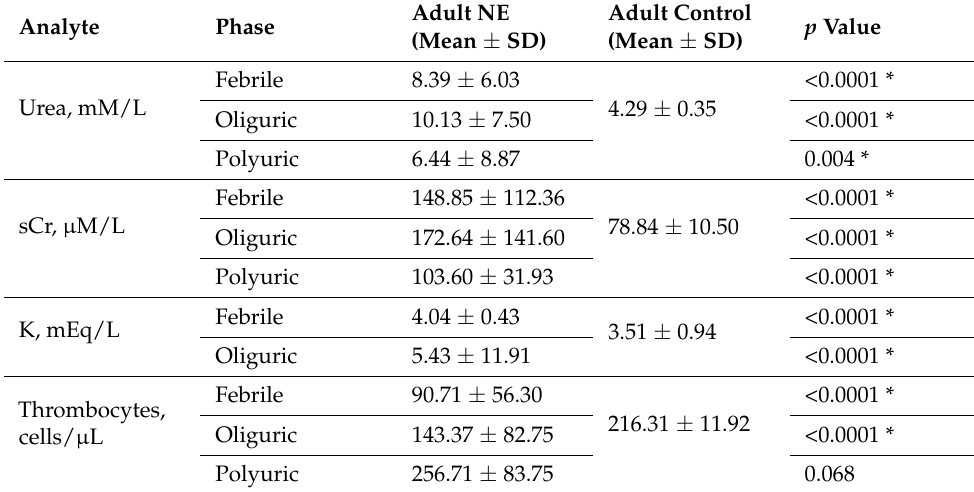
Table 2. Clinical laboratory testing results in adult NE patients and